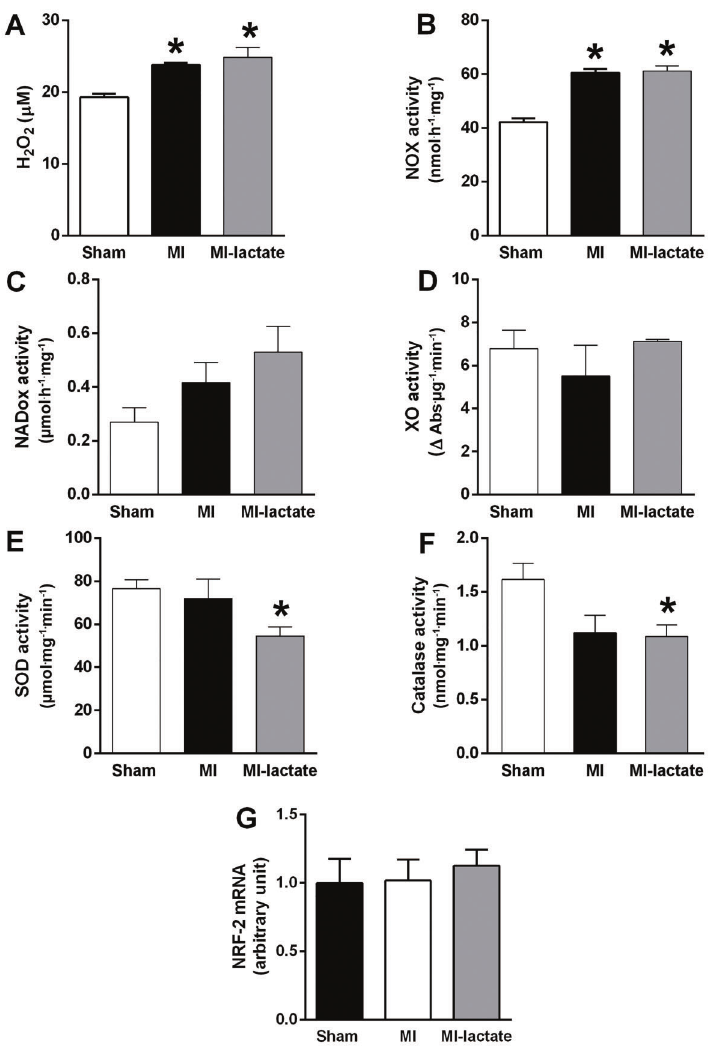
Figure 2. A , Reactive oxygen species (O 2 ? - / H 2 O 2 ) and activity of B , nicotinamide adenine dinucleotide phosphate oxidase (NOX), C , NADH oxidase (NADox), D , xanthine oxidase (XO), E , superoxide dismutase (SOD), F , catalase, and G , total nuclear factor erythroid 2-related factor 2 ( nrf-2 ) mRNA levels in hearts perfused for 60 min with Krebs-Henseleit (KH) and KH plus lactate. MI: myocardial infarction. Data are reported as means ± SE of 6 hearts. *P o 0.05 vs Sham group